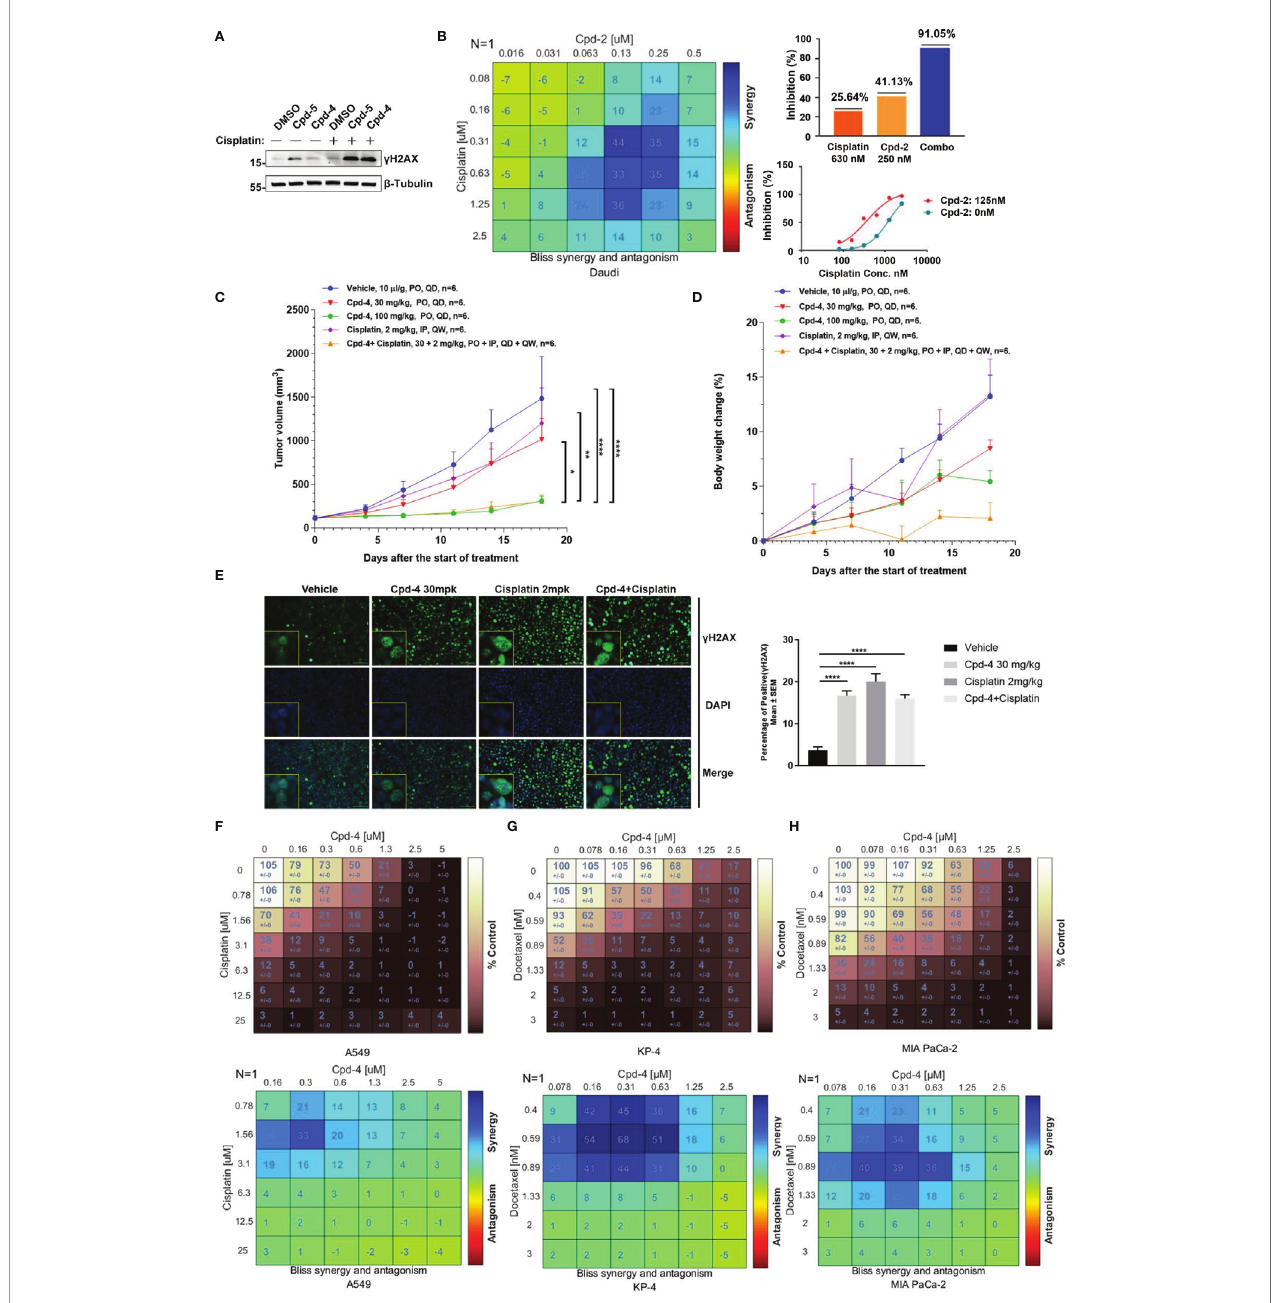
FIGURE 4 | RAD51 inhibition enhances the anti-tumor effect of chemotherapy agents. (A) Western blot analysis of g H2AX expression in cell lysate. Daudi cells were co- cultured with DMSO, Cpd-5 (50 nM) and Cpd-4 (25 nM) for 72 h, then cells were treated with 30 m M cisplatin for 2 h and recovered for 5 h. b -Tubulin served as loading control. (B) Synergy effect of compounds and cisplatin in Daudi cells. Cells were dosed with Cpd-2 and cisplatin in a 6×6 concentration grid in 96-well plate for 7 days. Cell viability was determined with CellTiter-Glo reagent. The experimental data were analyzed with bliss synergy model using the Combene fi t software (left panel) and GraphPad Prism software (right panel). Data are representative of at least two independent experiments. (C, D) The anti-tumor effects of Cpd-4 and cisplatin in the Daudi xenograft mouse model. The Daudi tumor bearing female BALB/c nude mice were administrated with Cpd-4, cisplatin or combination and the tumor volume and the body weight change are graphed in (C, D) , respectively (N=6 for each group). The error bars represent Standard Error of Mean. PO, oral garage; QD, once daily; IP, intraperitoneal injection; QW, once a week. P value was calculated based on the tumor volume using two-way ANOVA. *, P<0.05; **, P <0.01; ****, P <0.0001. (E) g H2AX expression in tumor tissue analyzed by fl uorescence histochemistry. For quanti fi cation, nuclei with ≥ 5 foci were counted as g H2AX-positive cells. A total of 4 fi eld with >100 cells were counted in each mouse. Mean ± SEM. Scale bar, 100 m M. (F) Synergy analysis of compounds and cisplatin in A549 cell lines. Upper panel, cell viability. Lower panel, bliss synergy score. (G, H) Synergy effect of compounds and docetaxel in MIA PaCa-2 and KP-4 cell lines. Data are representative of at least two independent